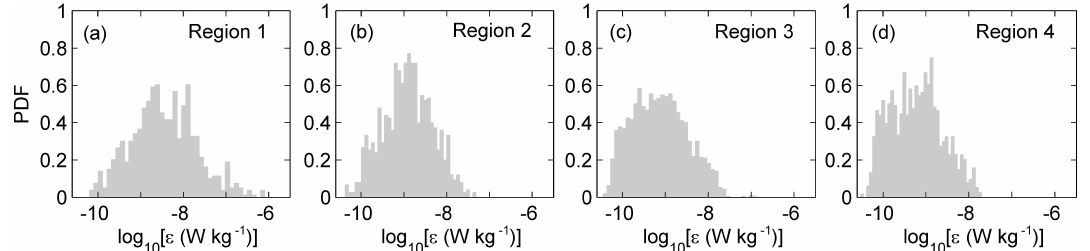
Figure 6. Probability density functions of dissipation rates in (a) region 1, (b) region 2, (c) region 3, and (d) region 4.